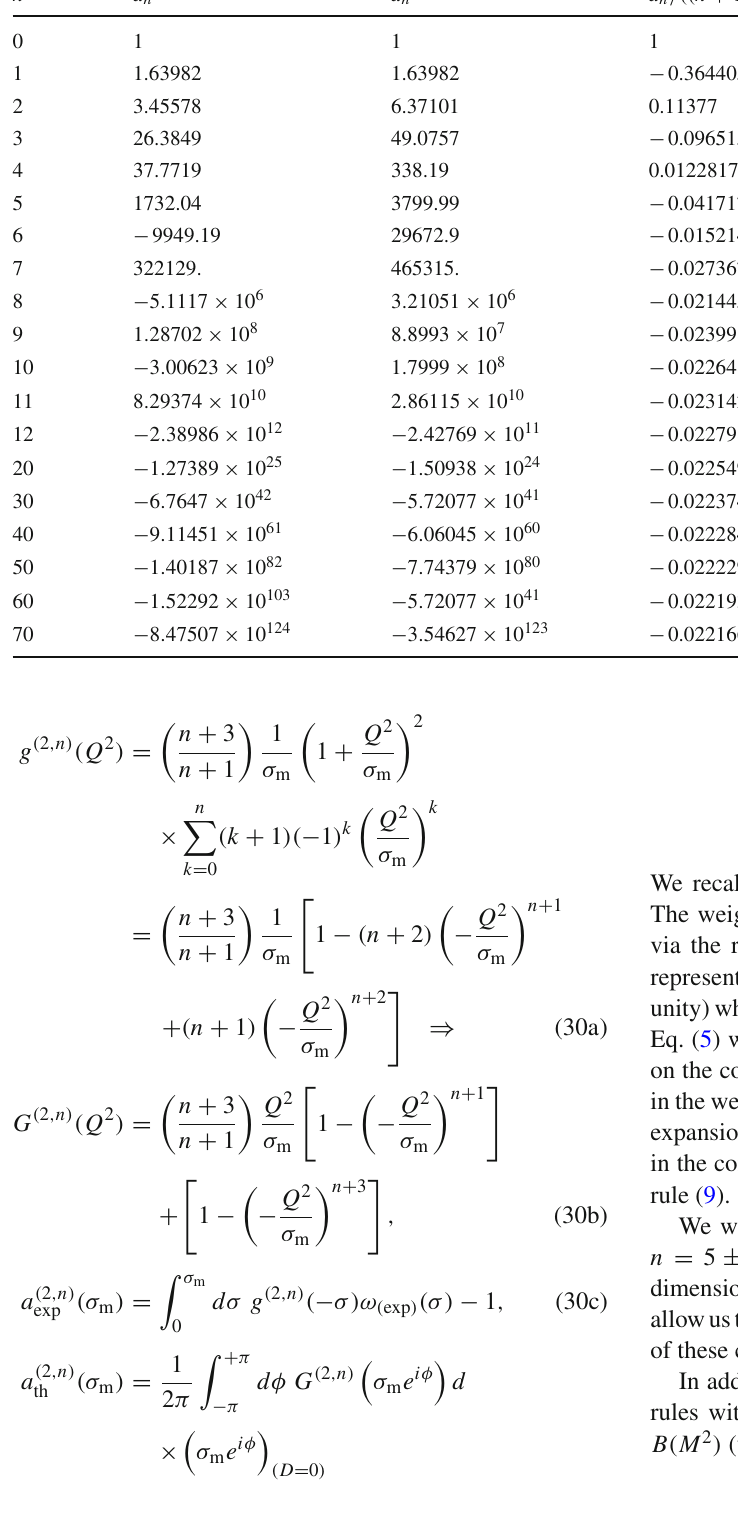
Table 2 The MS coefficients (cid:8) d n and d n (with κ = 1) of the consid- eredrenormalon-motivatedAdlerfunctionextension:thecoefficients (cid:8) d n are generated by the Borel transform Eq. (23) of the extended auxiliary